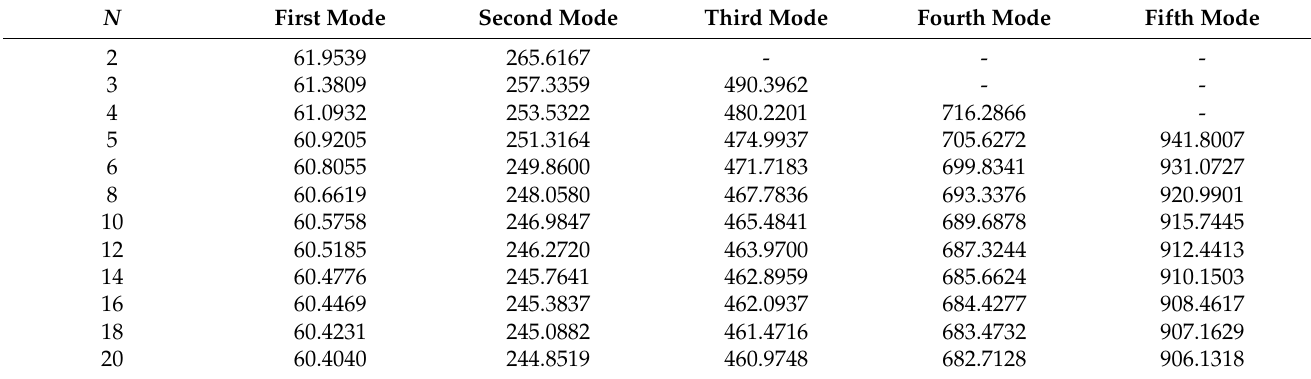
Table 1. Convergence characteristics of the dimensionless axial vibration frequencies when δ = 0 , α = 70, ϕ = 1, and γ = 10.